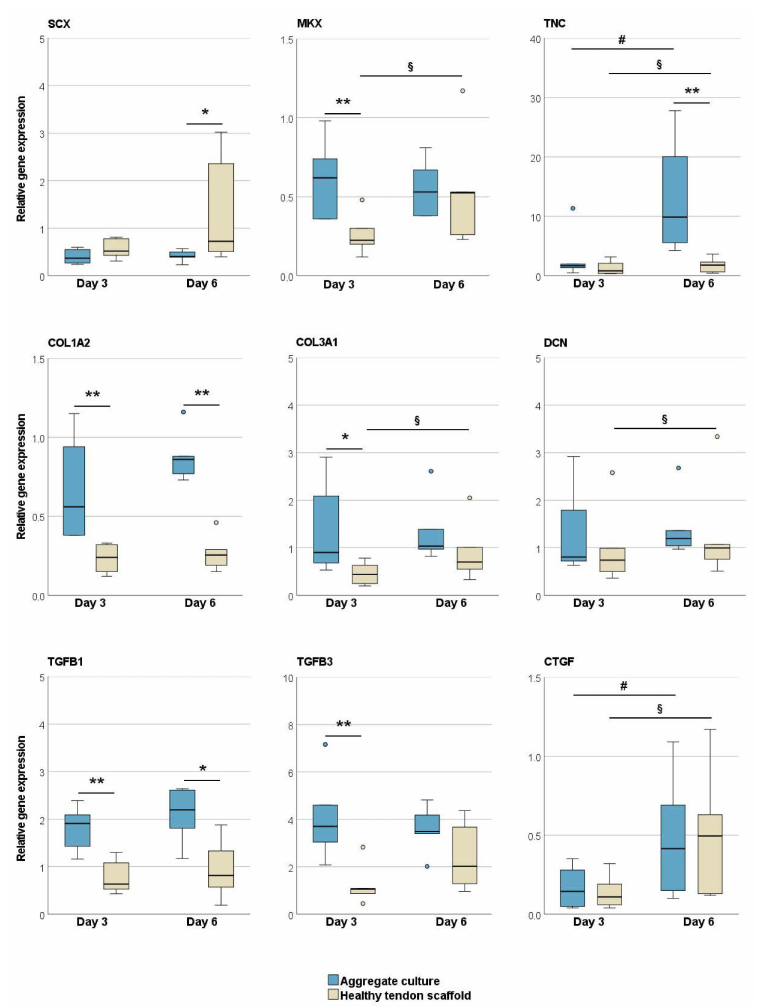
Figure 1. Relative gene expression of tendon-related genes and growth factors in MSC aggregate cultures and healthy tendon scaffold cultures. Asterisks indicate significant differences between groups with p < 0.05 (*) or p < 0.01 (**). Significant differences over time are indicated by hashmarks for aggregate cultures and by paragraph symbols for healthy tendon scaffold cultures ( p < 0.05). Data were obtained with MSCs from n = 6 donors. SCX: scleraxis; MKX: mohawk; TNC: tenascin-C; COL1A2: collagen I; COL3A1: collagen III; DCN: decorin; TGFB: transforming growth factor- β ; CTGF: connective tissue growth